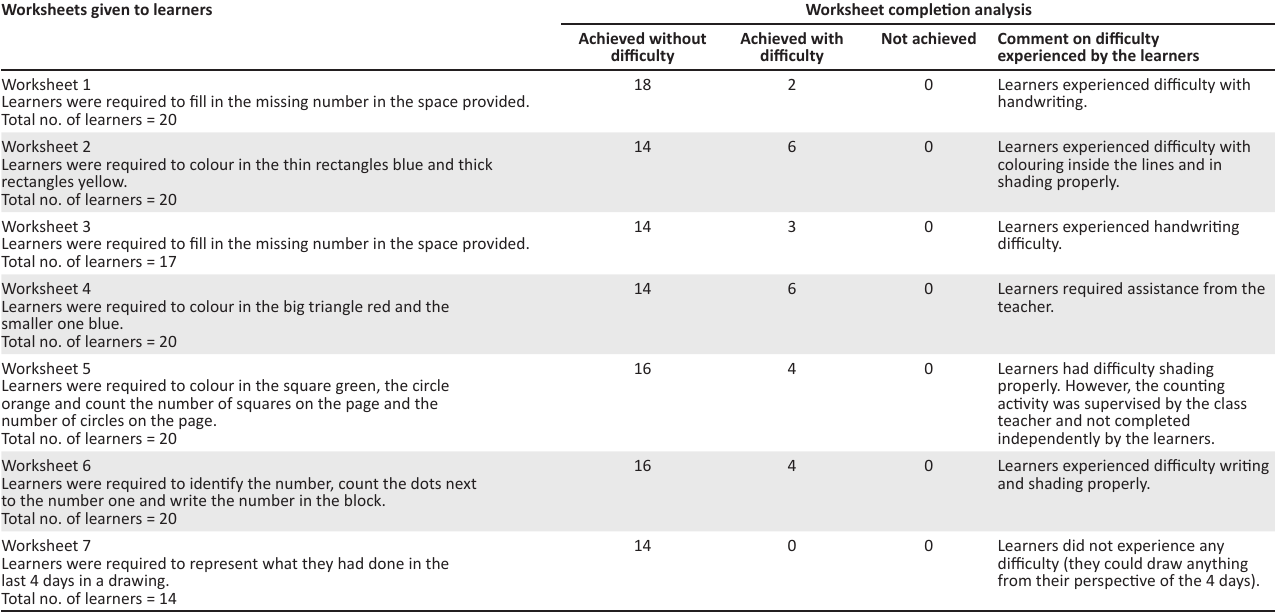
TABLE 2: Analysis of the worksheets as completed by the learners after the movement activity. Worksheets given to